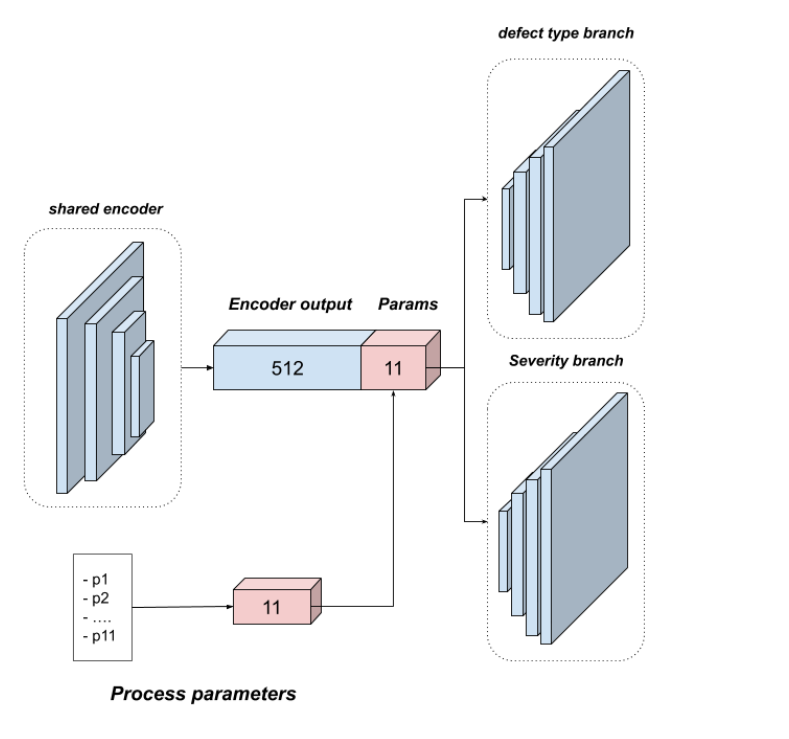
Figure 15. Incorporation of process parameters to improve model performance. After expanding the process parameter vector into a three-dimensional tensor, it is concatenated with the encoder output. The fused tensor then goes through both branches.